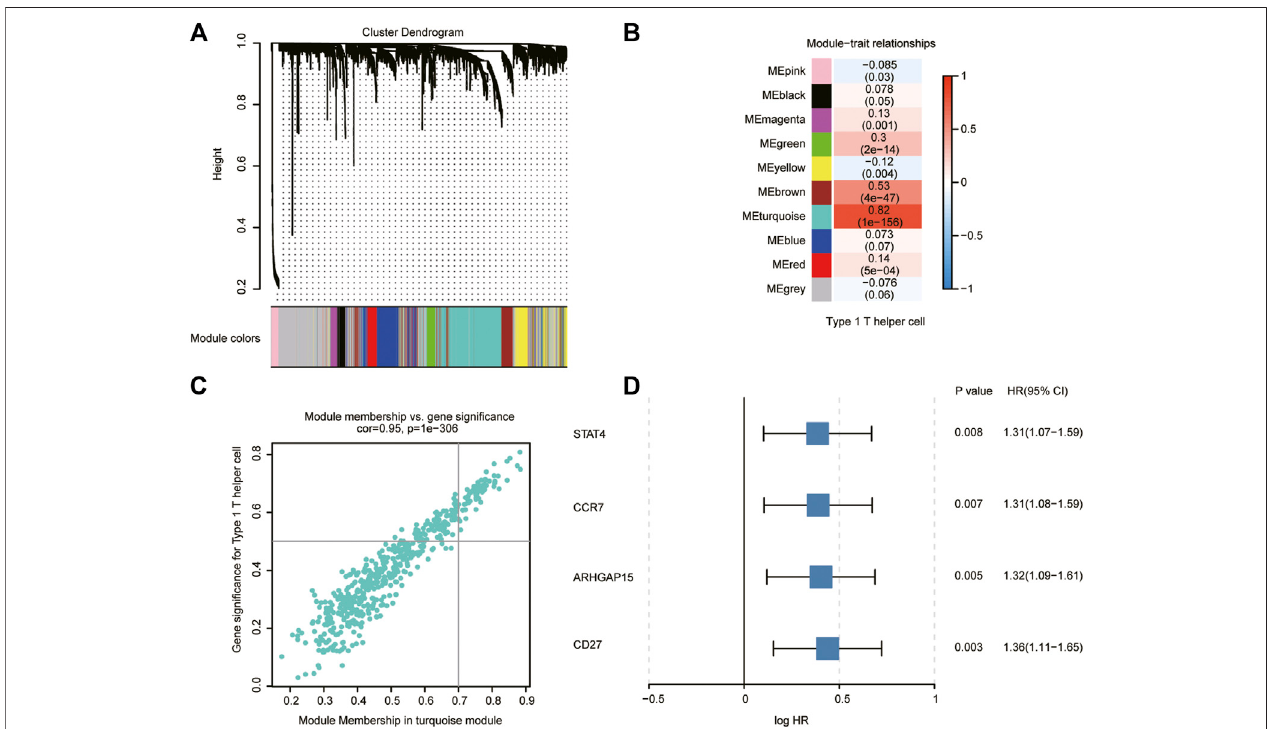
FIGURE 3 | Type 1 T helper cell – related gene signature identi fi cation. (A) WGCNA was performed to identify 10 modules by unsupervised clustering. (B) A total of nine modules (nongray) were identi fi ed. The turquoise module had the highest correlation (r = 0.82, P = 1e -156 ) and was considered the most correlated with type 1 T helper cells. (C) The gene signi fi cance and module membership of the genes in the turquoise module exhibited a high correlation. (D) A total of four type 1 T helper cell – related genes that were signi fi cantly associated with the prognosis of PDAC patients were identi fi ed among the hub genes extracted from the turquoise module. Abbreviations: WGCNA, weighted gene co-expression network analysis; PDAC, pancreatic ductal adenocarcinoma; HR, hazard ratio; CI, con fi dence interval.